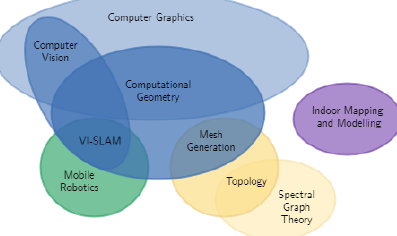
Figure 1. Euler diagram of fields that apply to the theoretical framework underlying the presented